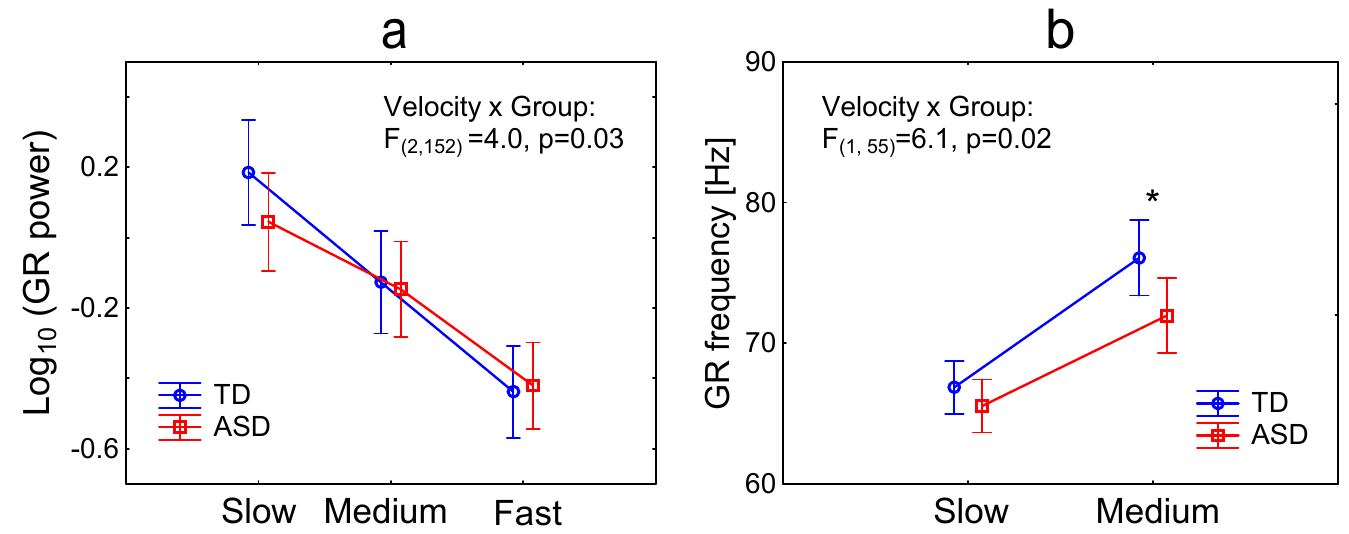
Fig 4. Velocity-dependent changes in gamma response (GR) power (a) and frequency (b) in TD and ASD children. The main figure in panel ‘b’ shows the results for children with reliable GRs in both the ‘slow’ and ‘medium’ conditions (N TD/ASD = 29/30). � p = 0.036, uncorrected for multiple comparisons.